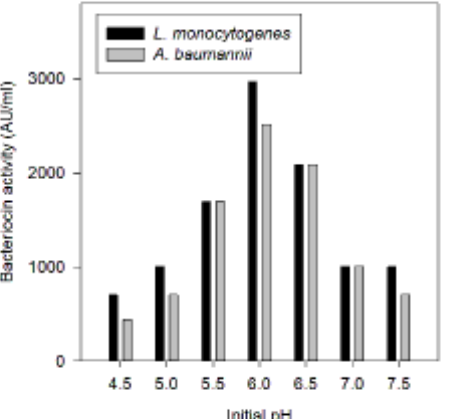
Fig. 3. Effect of different initial pH on bacteriocin production against Listeria monocytogenes MTCC657 and Acinetobacter baumannii MTCC 1425